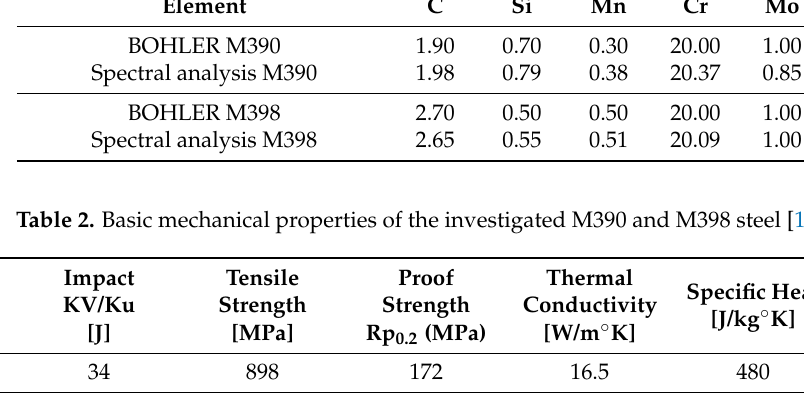
Table 1. Chemical composition of the investigated M390 and M398 steels (wt. %). Element